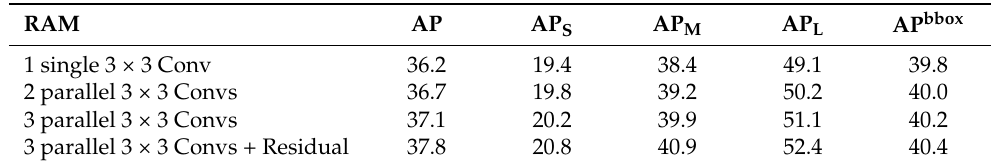
Table 4. Effectiveness of the residual-aware module. RAM denotes the residual-aware module. We conducted careful experiments on each part of the RAM. The dilated convolutions were increased in the order of dilated rates of 1, 2, and 3.